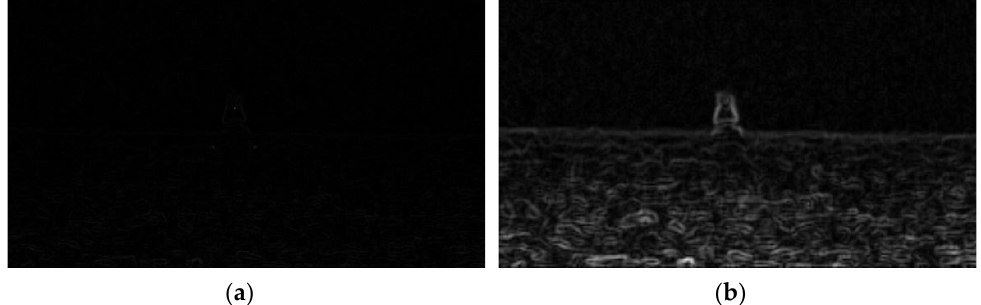
Figure 7. Extraction effect of improved Sobel edge detection algorithm: ( a ) traditional Sobel edge detection algorithm; ( b ) improved Sobel edge detection algorithm.